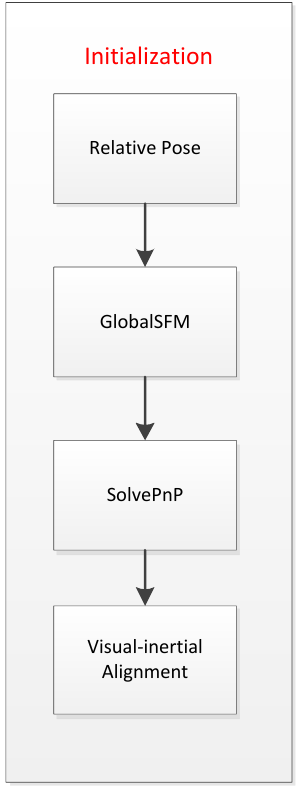
Figure 2. Initialization flow